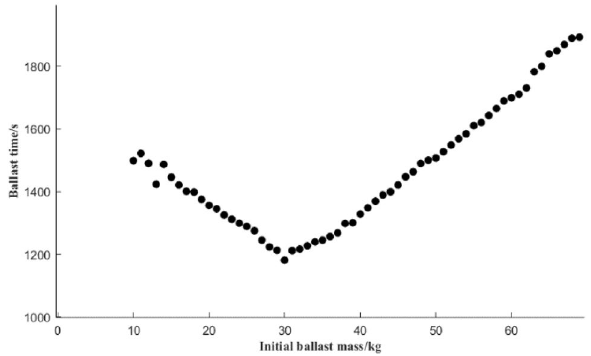
Figure 15. Influence of different initial ballast amounts on total deployment time.